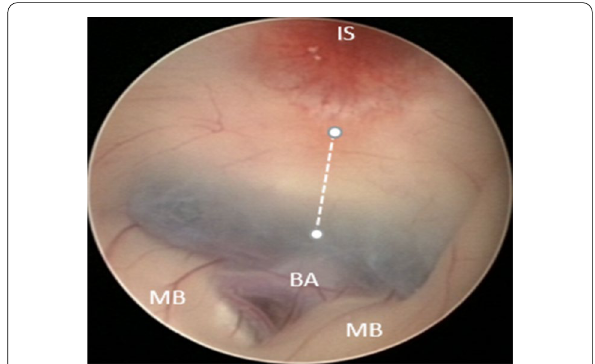
Fig. 2 Floor of 3rd ventricle showing the anatomical landmark for an ETV ostium (dotted white line). BA; basilar artery, IS; infundibulum stalk, MB; mammillary